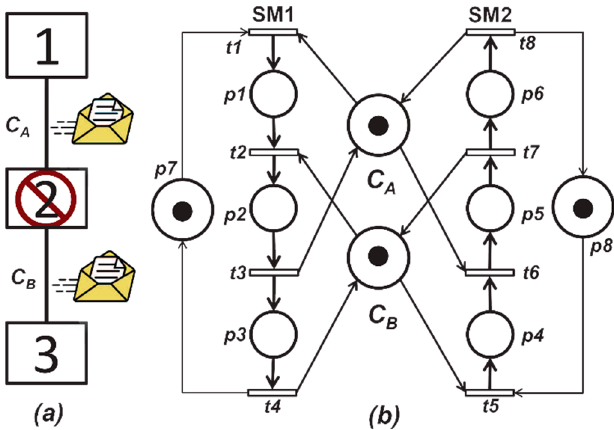
Figure 2. Modeling in binary ordered resources petri net (BORPN) class of the transport of a message using wormhole routing algorithm. ( a ) Representation of the System; ( b ) Petri net model of the system.